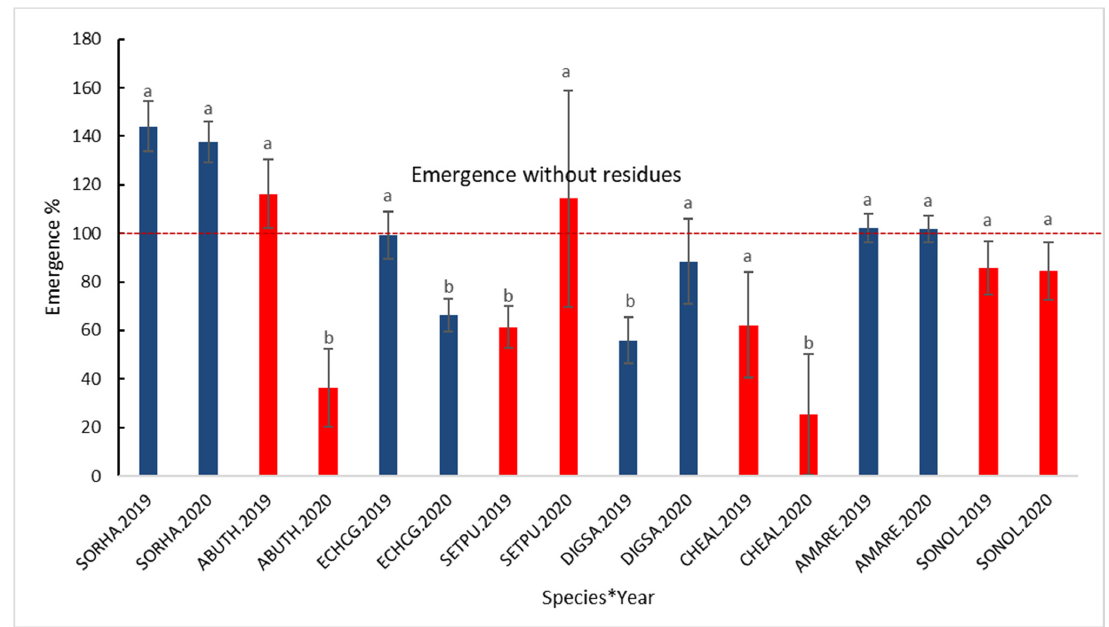
Figure 5. Differences in emergence between weed species in different years in the presence of crop residues. The emergence is expressed as a percentage of control (no residues). Emergence values are means of the two types of residues (wheat and maize) and three levels (0.5, 1, and 1.5) of residues quantities. Different letters indicate significant difference ( p -value < 0.05), and the bars indicate the standard